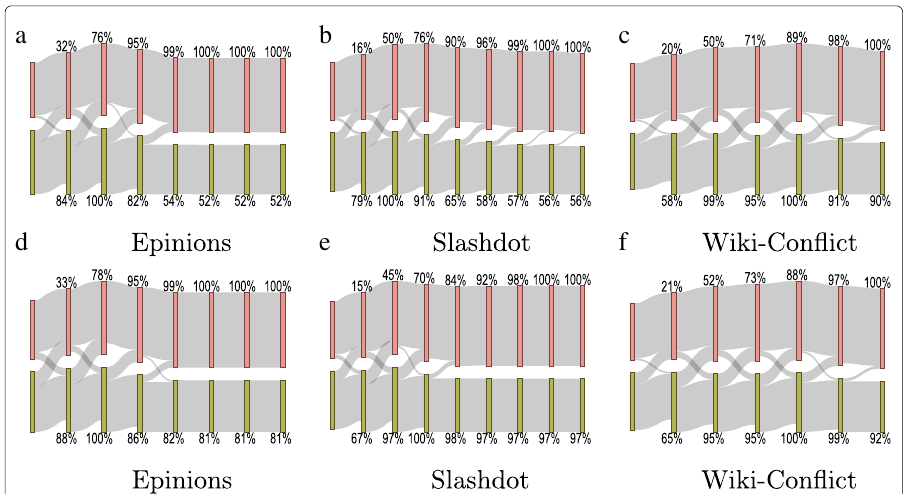
Fig. 13 spC - F 2 DLT : spread of I-Sources (red) vs. Stress-Triads (green), for ( a )-( c ) the unbiased scenario and ( d )-( f ) the biased scenario of activation-threshold function, with δ set to 1 and 0.1, respectively, and k =